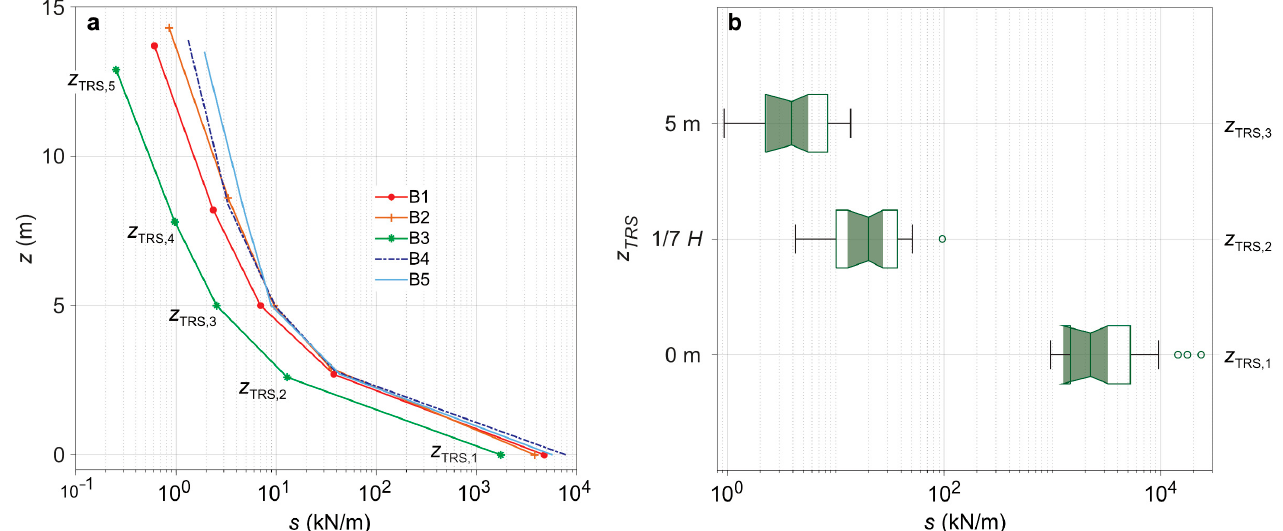
Figure 4. ( a ) Vertical profiles of the slope ( s ) calculated by a linear regression ( p < 0.001) between smoothed displacement ( D LP ) and horizontal component of the pulling force ( FP LP ) at TRS measure- ment heights z TRS,1 to z TRS,5 resulting from static pulling tests at sample trees B1 to B5. Due to the large s range, the x-axis is logarithmically scaled. ( b ) Boxplots of s at z TRS,1 to z TRS,3 resulting from static pulling tests at sample trees B1 to B35.